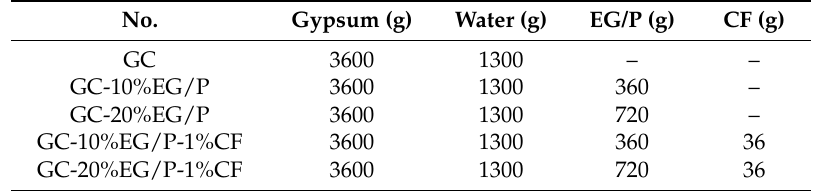
Table 1. The mix proportions of EGPG (expanded graphite/paraffin gypsum-based composite materials). No. Gypsum (g) Water (g) EG/P (g) CF (g) GC 3600 1300 – – GC-10%EG/P 3600 1300 360 – GC-20%EG/P 3600 1300 720 – GC-10%EG/P-1%CF 3600 1300 360 36 3600 1300 720